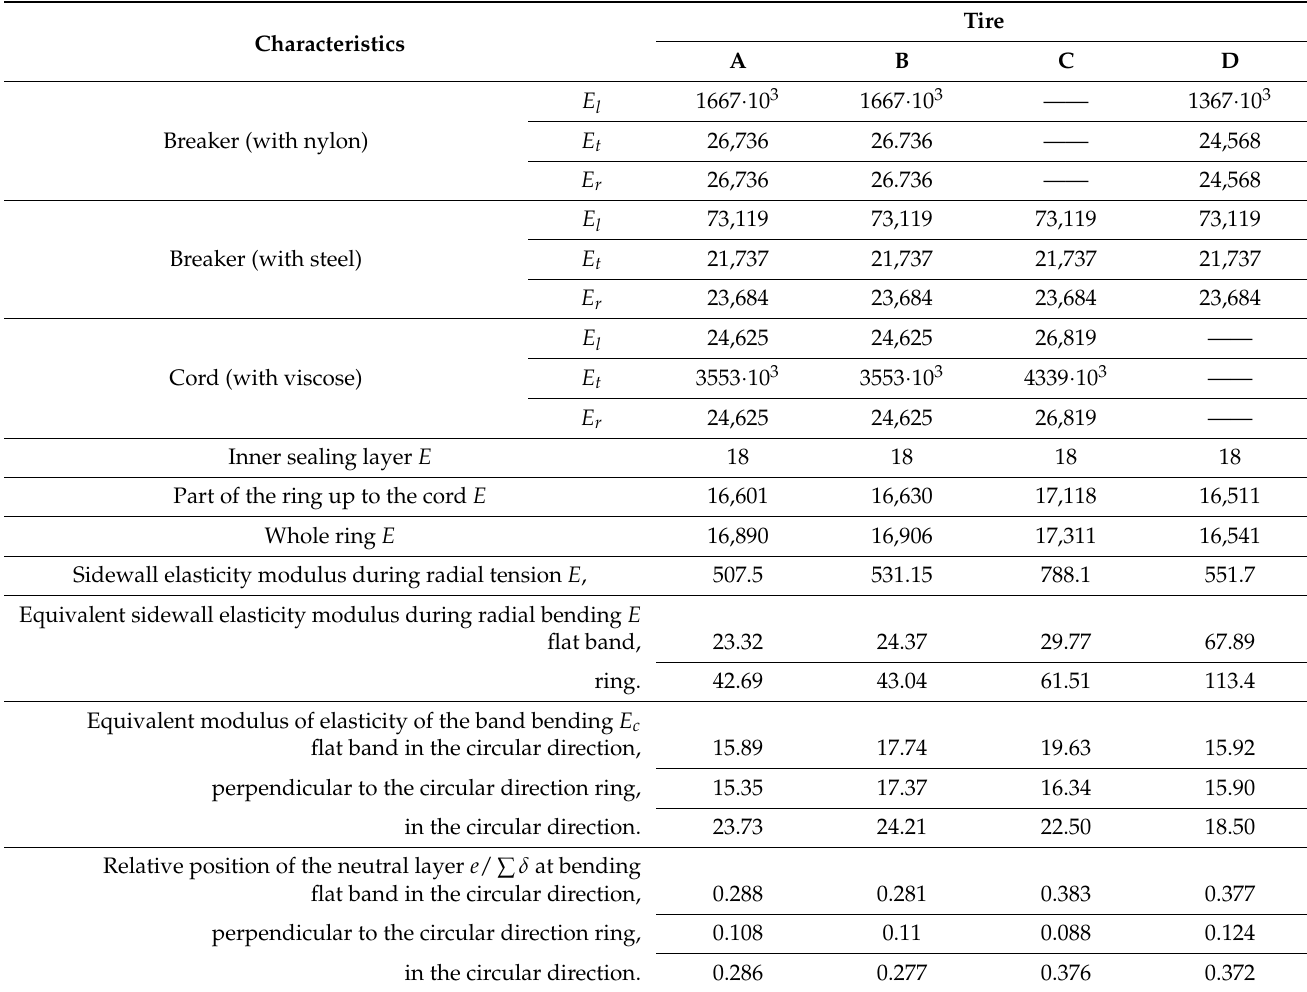
Table 2. Modulus of elasticity of the tire elements, MPa.